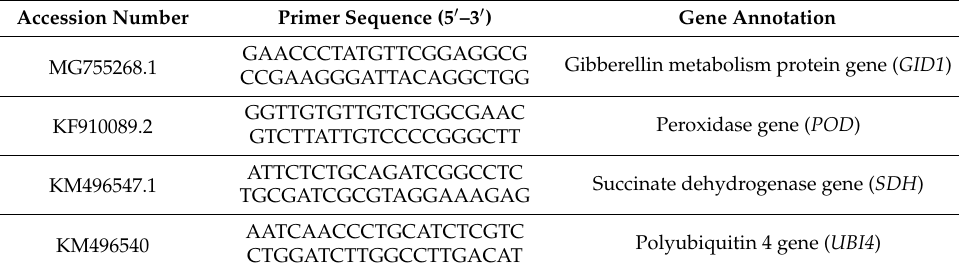
Table 1. The primer sequence and annotation information of candidate genes used in this